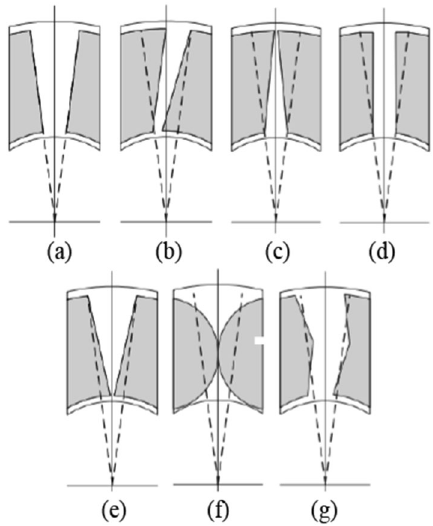
Figure 31 AFPMSM skewing techniques: a Unskewed, b Conventional, c Triangular, d Parallel-sided, e Trapezoidal, f Circular, and g Dual skewed